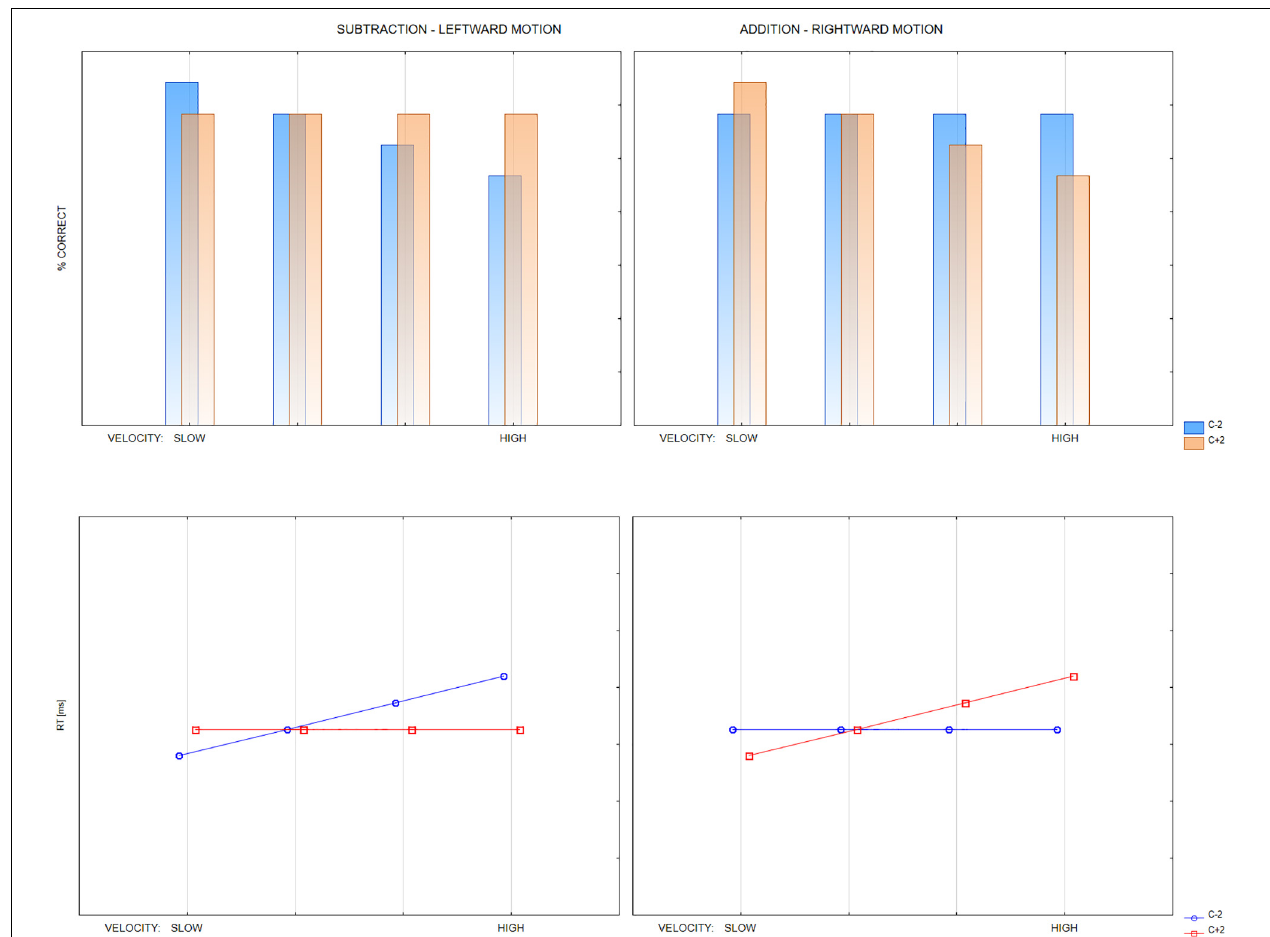
FIGURE 2 | Hypothetical distributions of accuracy and reaction times, assuming a strict analogy hypothesis between OM and RM. 4-way interaction of the arithmetic OPERATION , DIRECTION OF MOVEMENT of the operands, VELOCITY of movement, and the OUTCOME OPTION (too low: c–2, too high: c + 2). Subtraction effects predicted only for leftward movement, addition effects only for rightward movement. Possible effects due to other factors (e.g., overall better performance in addition than subtraction) are not